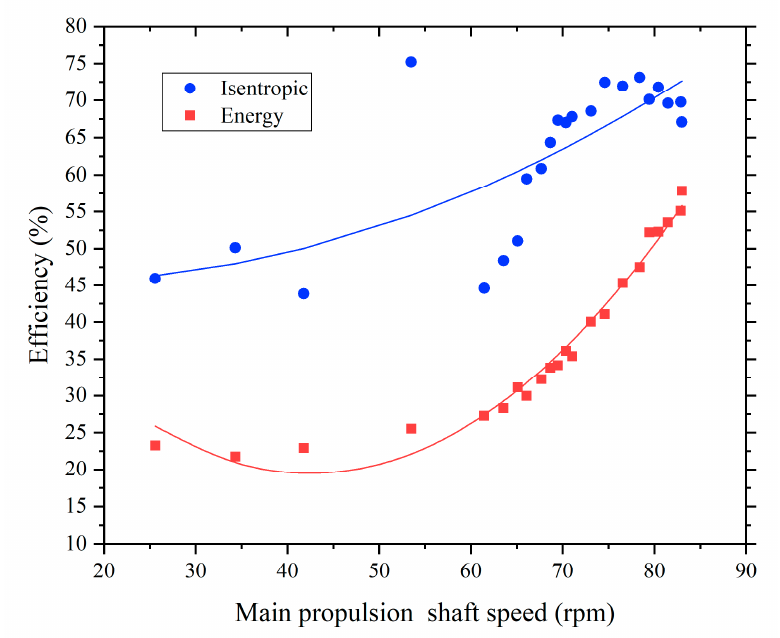
Figure 5. Isentropic and energy efficiency.